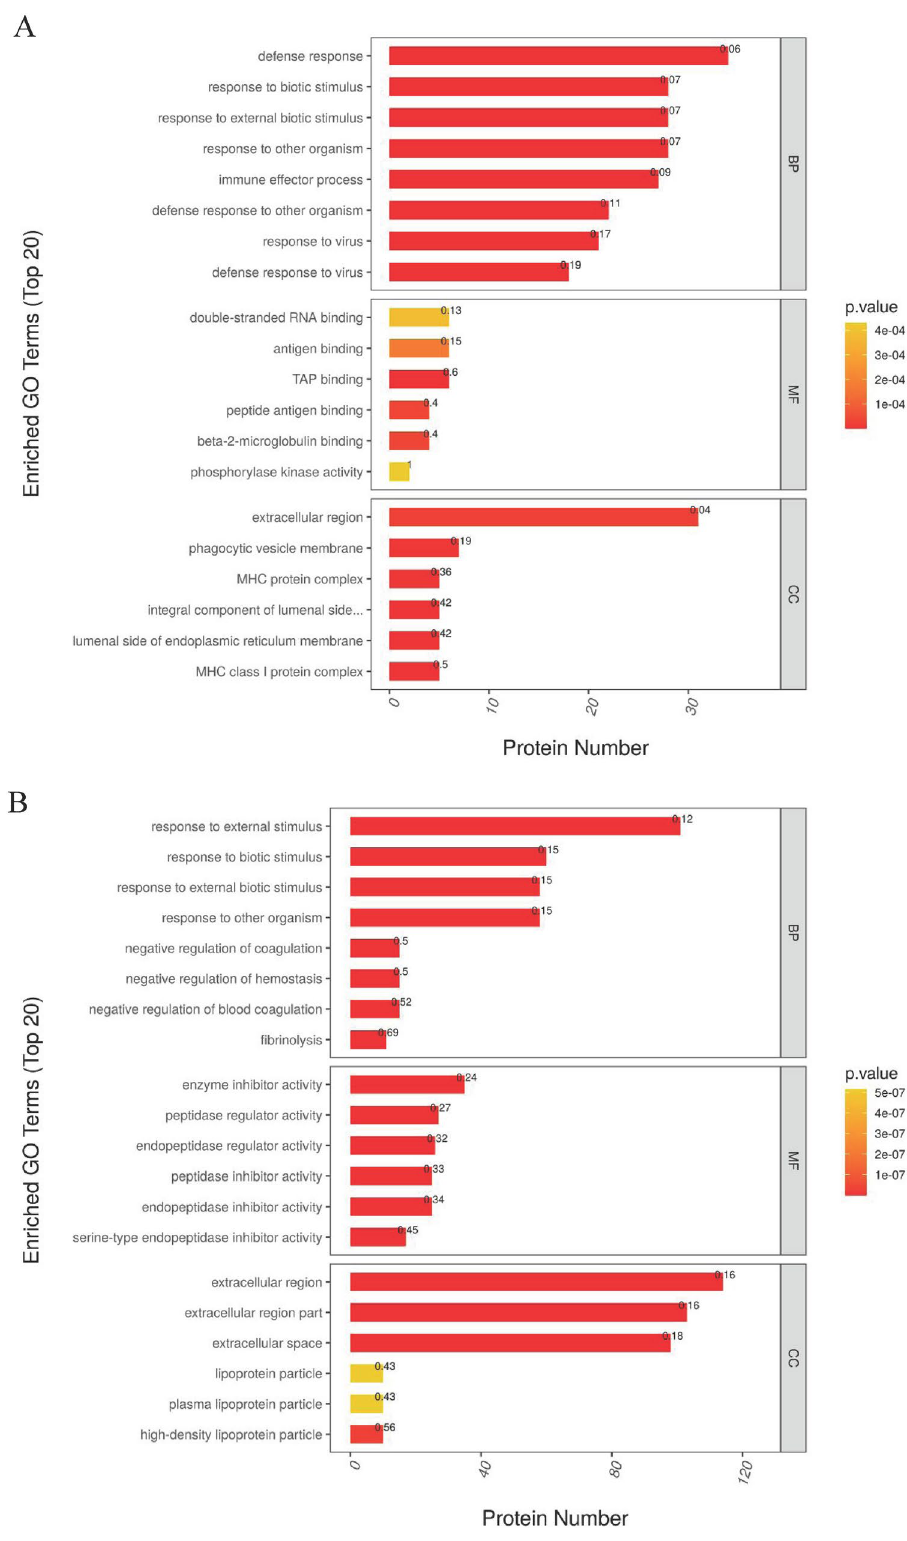
Figure 3. Gene ontology (GO) functional enrichment analysis of differentially expressed protein of proteomics treated with PZH ( A ) and sora ( B ). Functional classification is divided into biological process (BP), molecular function (MF) and cellular component (CC). Red represents the smaller p value than orange, corresponding to the higher significance level of the enrichment of the functional category. The label above the bar graph shows the enrichment factor, which indicates the ratio of differentially expressed proteins to all identified and annotated